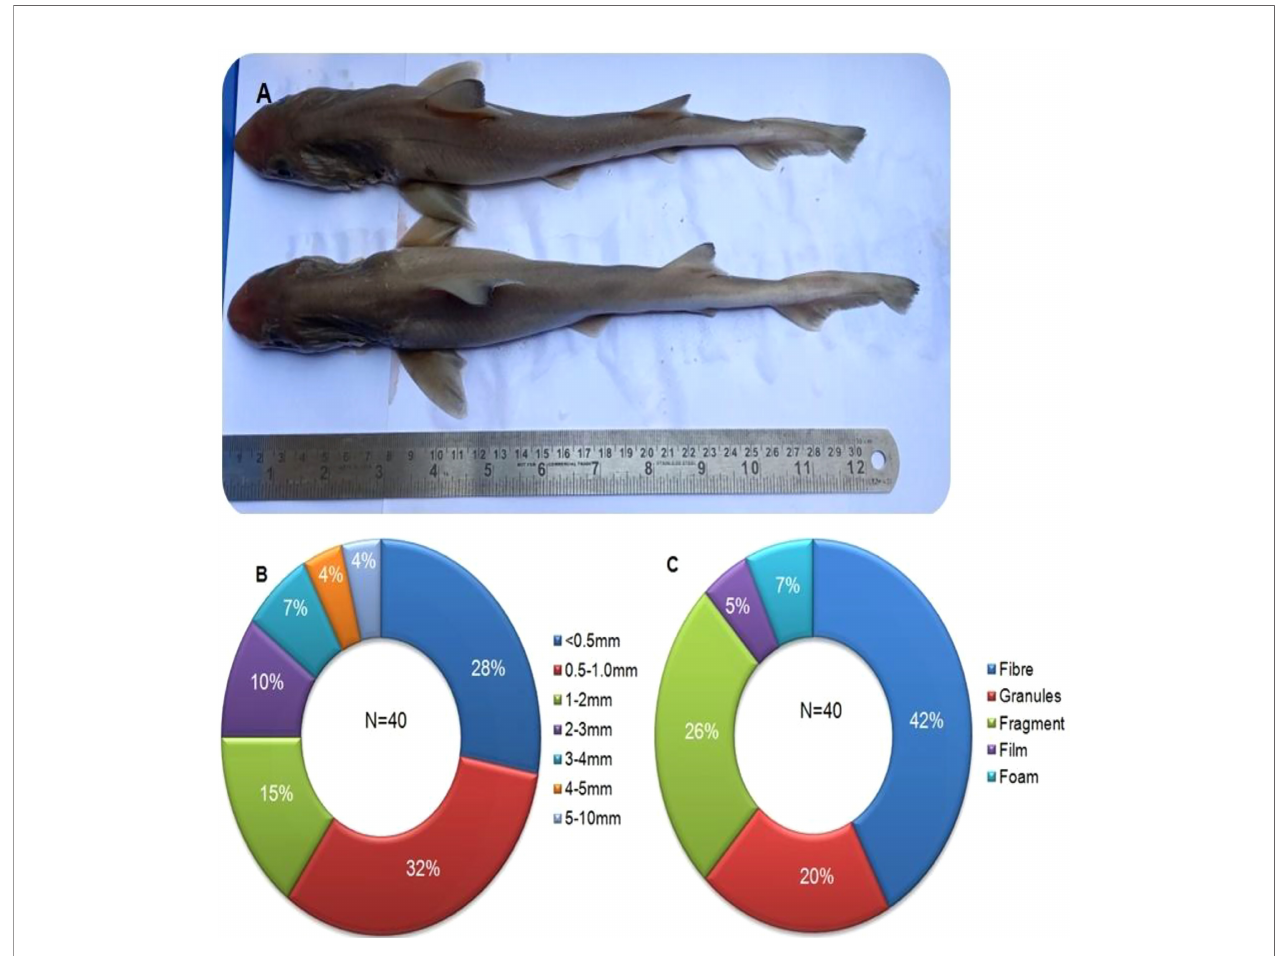
FIGURE 1 | Shark fi sh samples collected and analyzed for microplastics (A) Juvenile male shark (B) Pie diagram showing percentage of different size of microplastics (C) Pie diagram information showing percentage of different type of